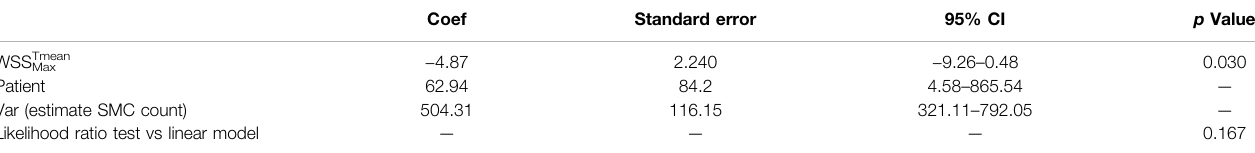
TABLE 6 | Multilevel mixed effects linear regression: association between wall shear stress (WSS Tmean Max ) and smooth muscle cell (SMC) count. The fi xed effects part of the model tests the effect of WSS Tmean Max on SMC count. Random effects part of the model tests the effect of the data being nested with the patient domain.